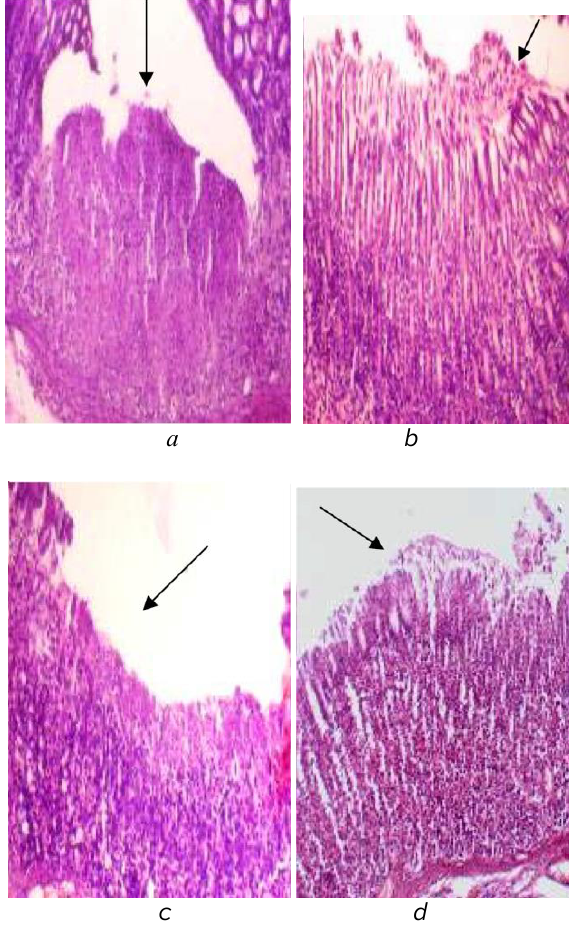
Fig. 8. The stomach of rats injected with dry cabbage extract at a dose of 30 mg/kg (a, b) and 40 mg/kg (c, d) against the background of an alcohol-prednisolone mix- ture: a – the ulcer defect is spread to the entire depth of the mucous membrane of the prepyloric section;